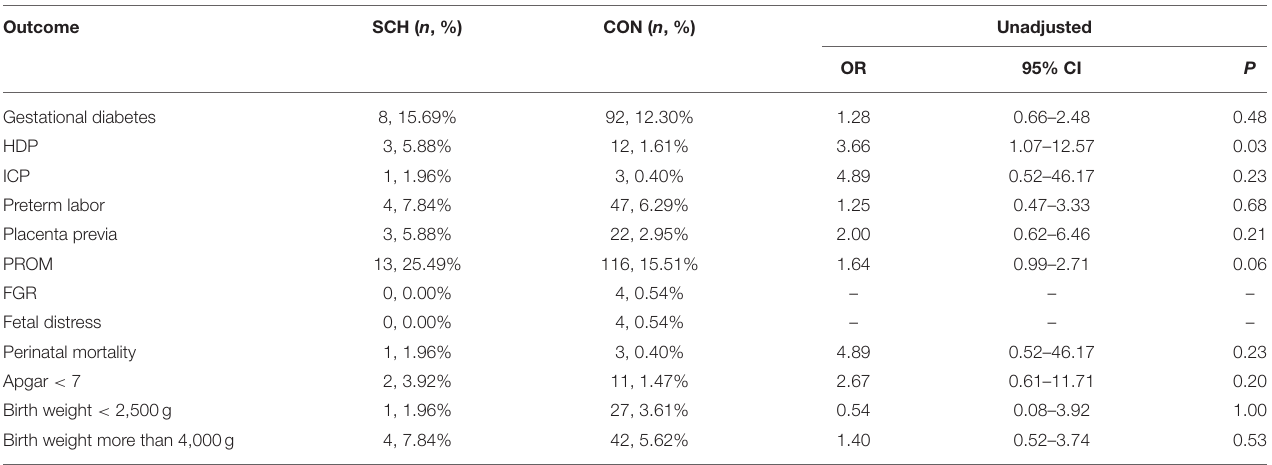
TABLE 4 | Adverse perinatal outcomes in women diagnosed with SCH in the second trimester.